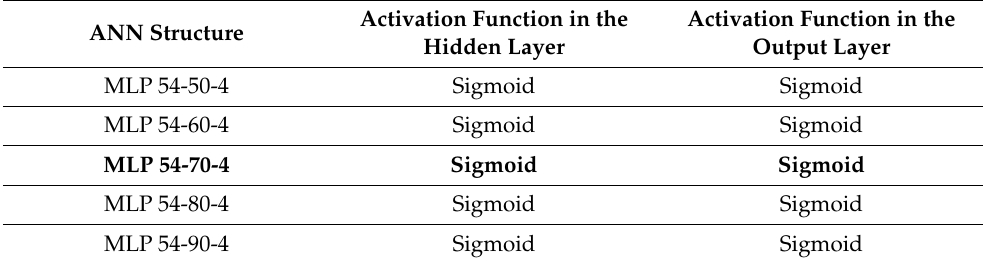
Table 7. The best MLP network models for diagnostic